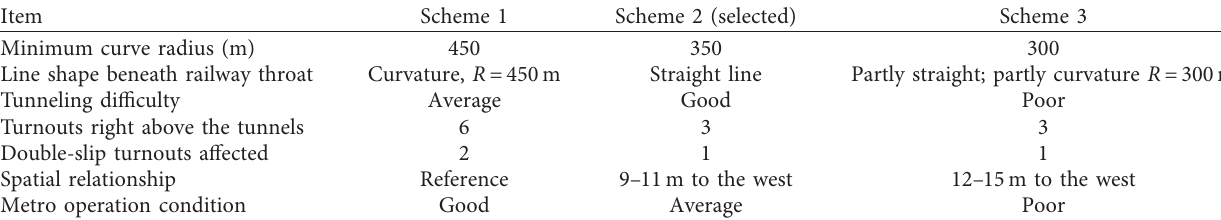
Table 3: Comparison of line alignments.